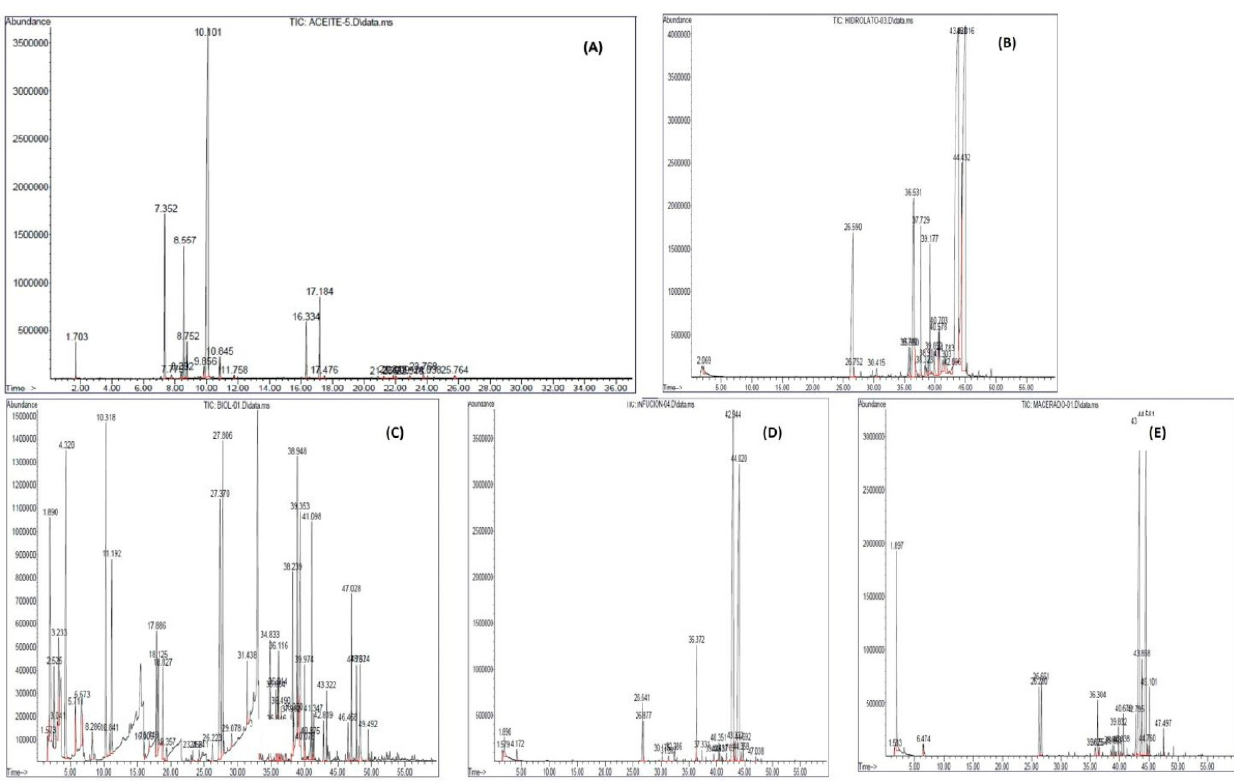
Figure 1. Results of the chemical composition using gas chromatography coupled to mass spectrom- etry of the biopesticides obtained from Cymbopogon citratus to be used in the control of coffee rust ( A ) oil, ( B ) biol, ( C ) hydrolate, ( D ) infusion, and ( E ) macerate.